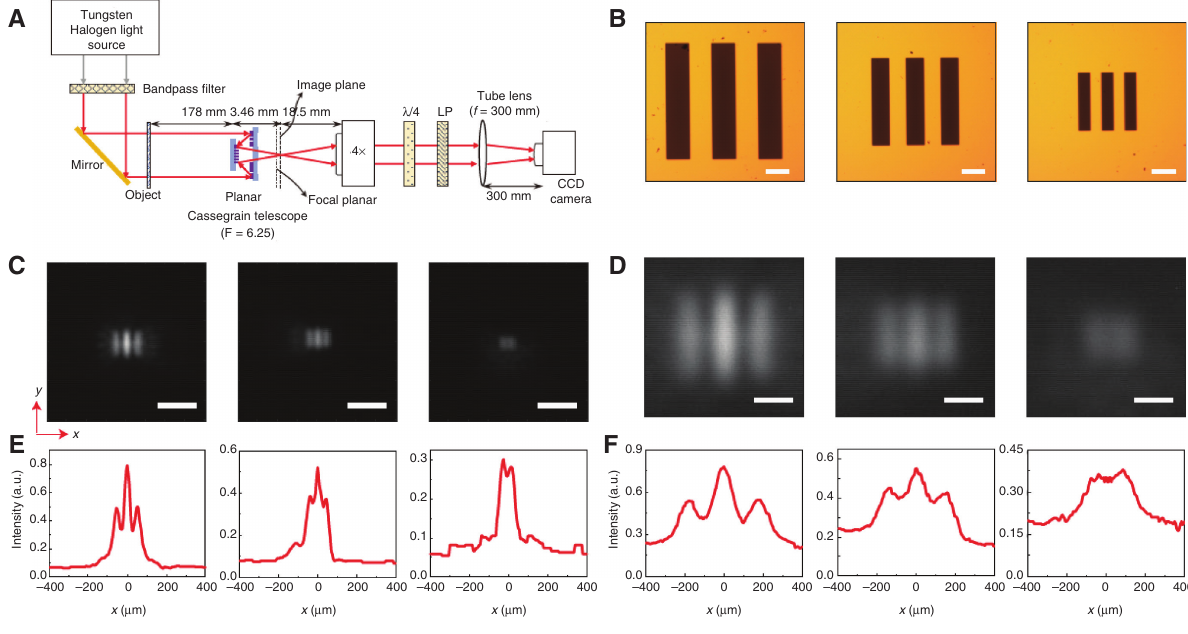
Figure 4: Imaging with the Cassegrain metasurface telescopes. (A) The experimental setup for charactering the imaging properties of the metasurface telescope with F = 6.25. A Tungsten-Halogen light source is used as an illumination. A bandpass filter (Thorlabs, FB780-10, 780-nm center wavelength, 10-nm FWHM) is placed behind the light source to reduce chromatic aberrations. Patterns milled in a 100-nm-thickness gold film on glass substrate are used as the objects. The image collected by the Cassegrain metasurface telescope is magnified by the combination of the objective lens (Olympus, 4 × magnification, NA = 0.1) and the tube lens with focal length f = 300 mm and then projected onto the CCD camera. (B) The optical photographs of the objects (scale bar: 100 μ m). The center to center distance of the slit is 200 μ m, 150 μ m, and 100 μ m from left to right. The dark areas (slits) are transparent and their widths are respectively 100 μ m, 75 μ m, and 50 μ m. (C, D) Images taken with the Cassegrain telescopes with F = 6.25 and 20, respectively. (E, F) The corresponding cross-sections of the images in (C) and (D) along the x direction. The magnifying ratio of the imaging systems are ~ 0.3 and ~ 1. Scale bar: 200 μ